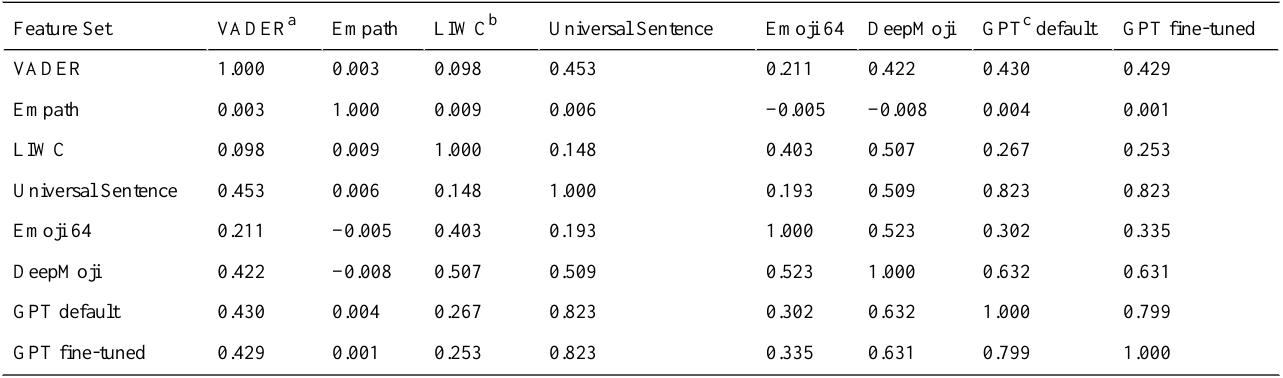
Table 2. Mantel correlations between the extracted feature